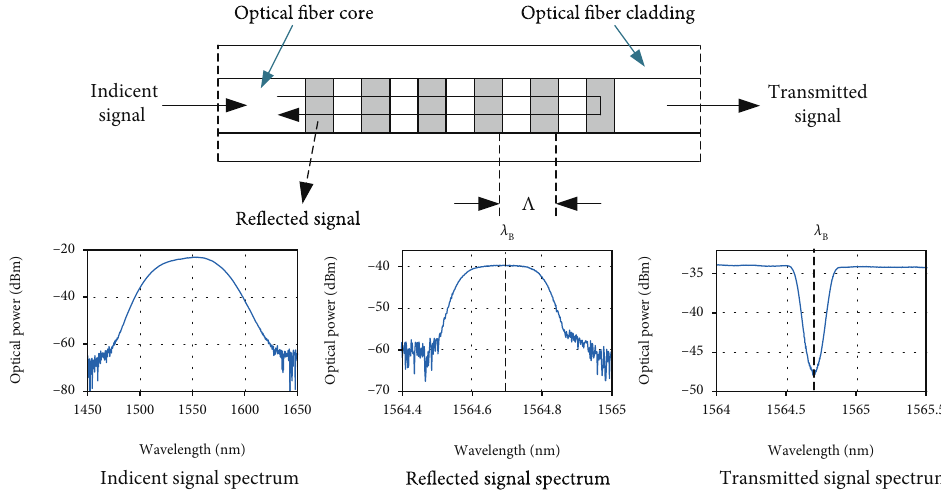
Figure 1: Structure and working principle of FBG sensors.